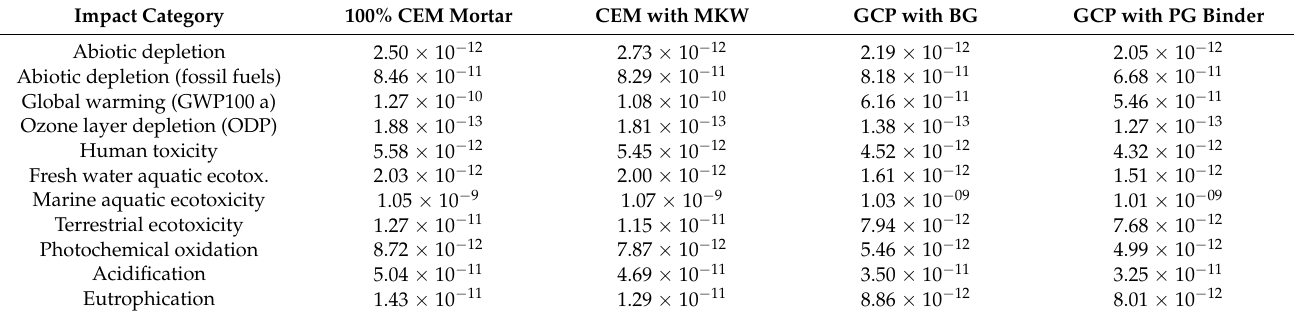
Table 3. Normalized impact to the environment for different types of